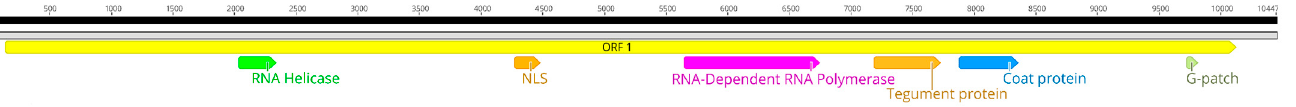
Figure 1. Genome organization of the Penaeus vannamei solinvivirus (PvSV). The genome consists of one large ORF with five identified conserved domains including an RNA helicase (green), Nuclear localization signal (orange), RNA-dependent RNA polymerase (pink), tegument protein (orange), Calicivirus coat protein (blue) and G-patch (light